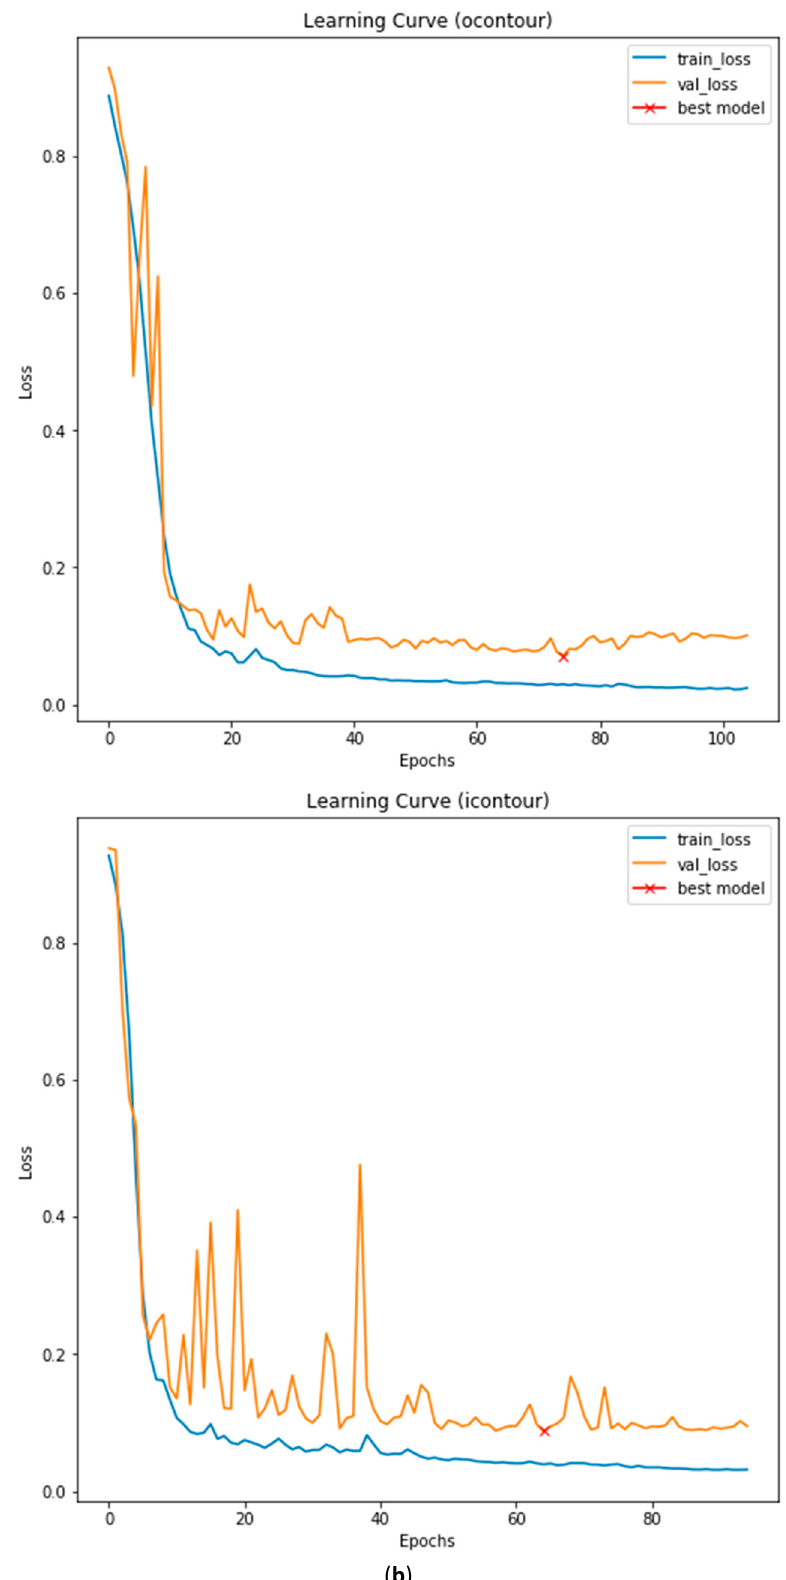
Figure 9. ( a ): Learning curve during training minimizing dice loss for epicardium (top) and endo- cardium (bottom) using the Elu activation. ( b ) Learning curve during training minimizing binary cross-entropy for epicardium (top) and endocardium (bottom) using the Relu activation.